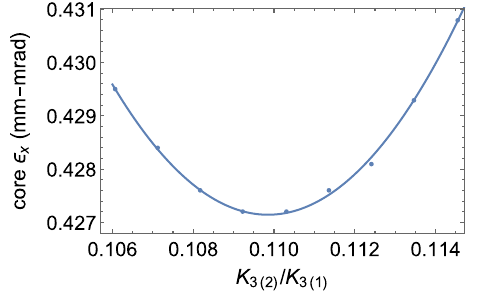
FIG. 6. The normalized core projected emittance with varying octupole strength ratios maintaining the total U 5666 from ELEGANT simulations (points) with quadratic fit (line).